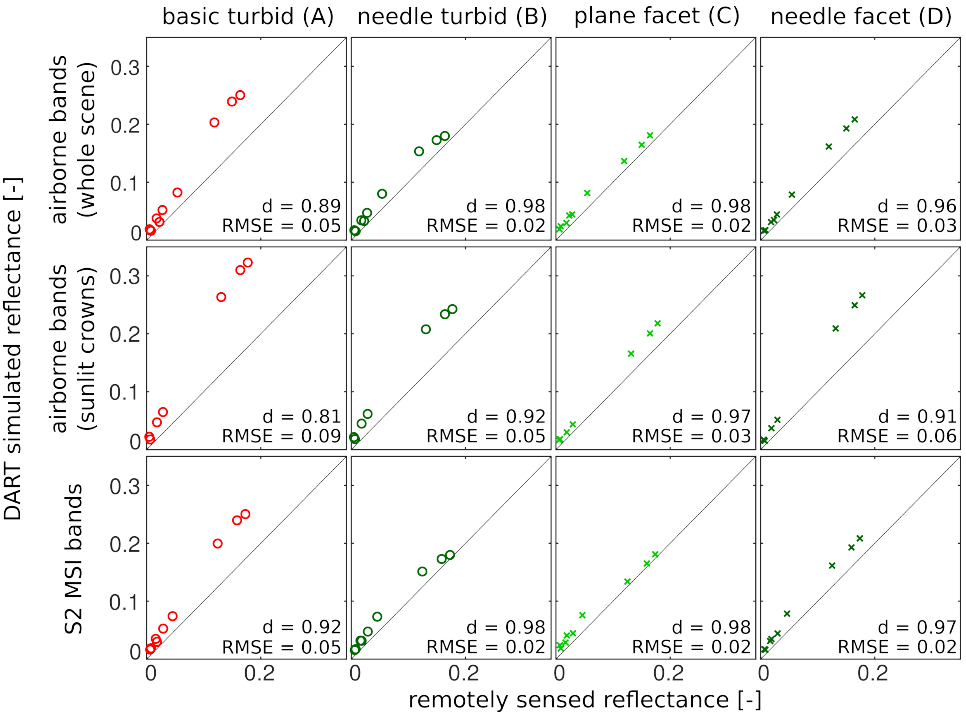
Figure 12. Scatterplots between DART-simulated and remote sensing (RS) data extracted from spruce forest stand reflectance. Top row: average stand reflectance extracted from CASI–SASI image, middle row: average reflectance of sunlit tree crowns extracted from CASI image, and bottom row: canopy reflectance extracted from Sentinel-2 MSI image (only narrow spectral bands with spatial resolution ≤ 20 m that are not affected by atmospheric water absorption are plotted). In order to provide statistically comparable data sets, the open circles in the case of airborne data (top and middle row) represent wavelengths corresponding to the Sentinel-2 MSI spectral